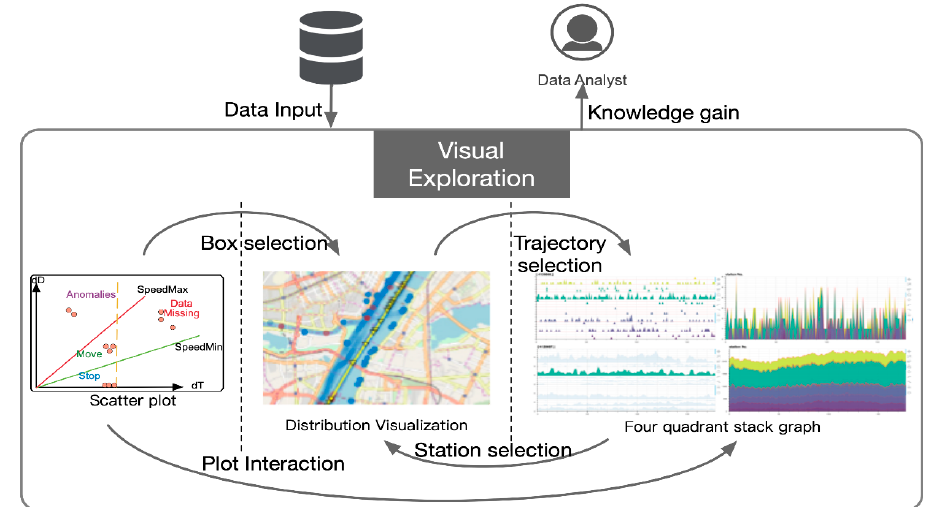
Figure 2. Analysis flow diagram.